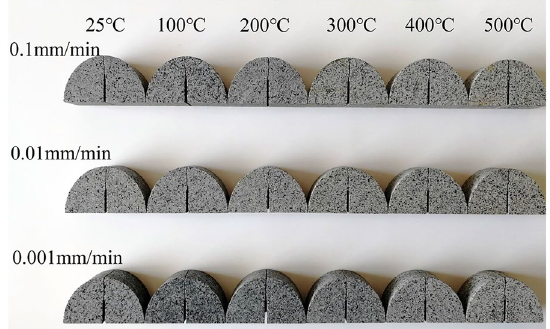
Fig. 7 NSCB samples after